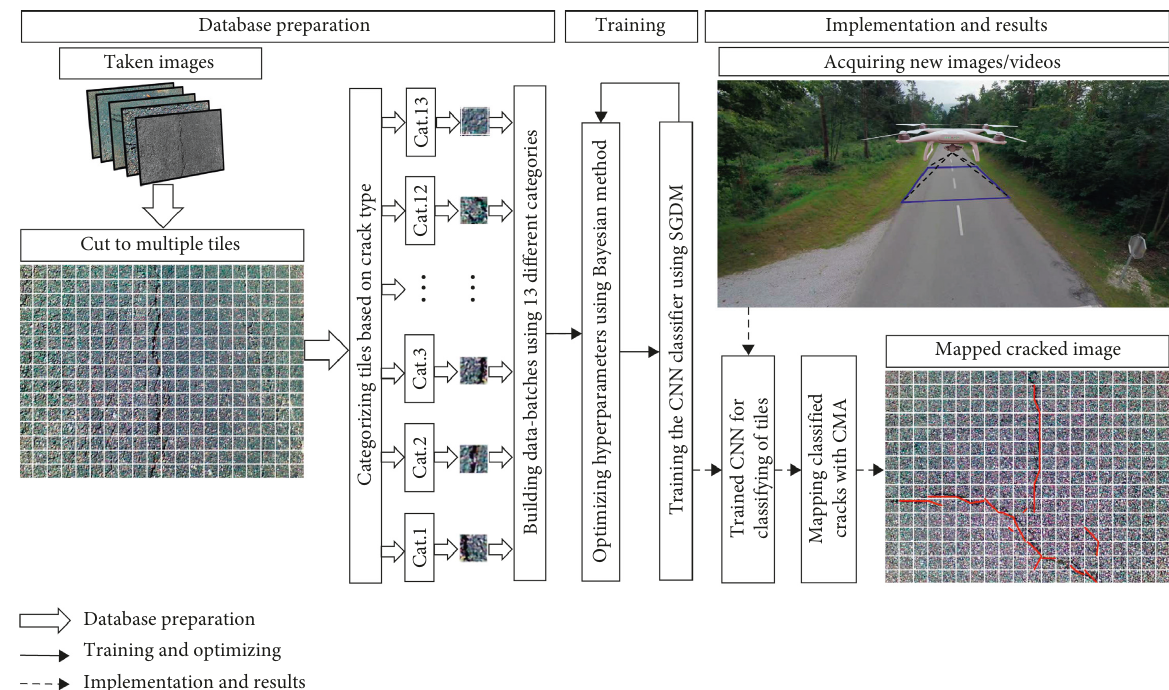
Figure 1: Flow chart for crack detection and